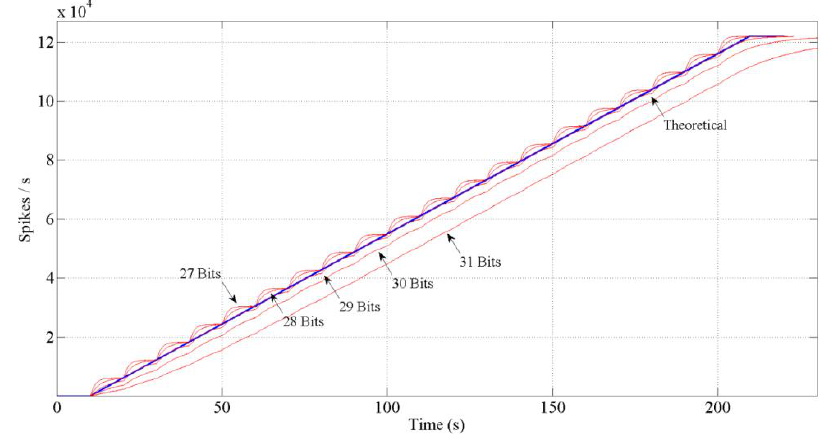
Figure 8. Comparison between five different bits implementations of the integrate and generate in the low pass filter. The theoretical behavior is also represented. The results performed with 27, 28 and 29 bits for the counter show a jumping behavior due to the saturation of the integrator. The higher the number of bits used, the slower the behavior. There is a trade-off between the desired speed and the avoided saturations. The slope used was 0.1% and the input 6.1 Kevents/s. In this case, the number of bits selected would be 29 (10% slope will use 21